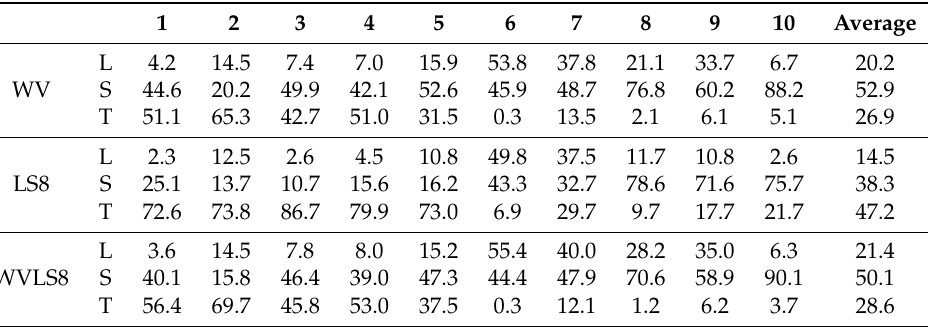
Table A8. Full area estimates. Percentage of each region covered by each class, by classifier. Note: for full classification of each 1000 km 2 region, we used the labeled examples from within that region as a training set. (Percentages may not add perfectly to 100 due to